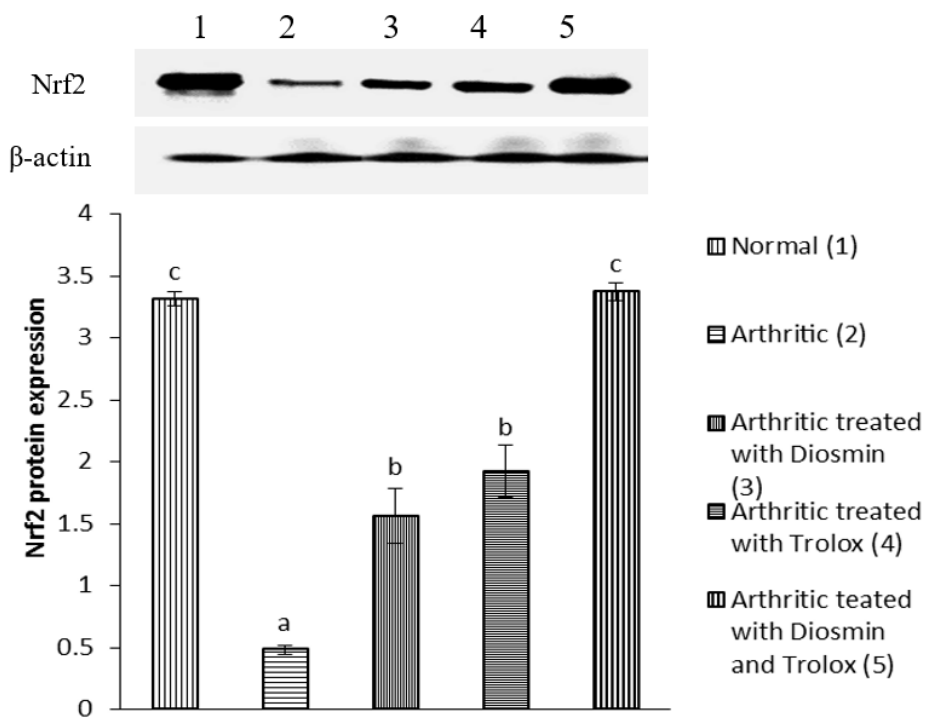
Figure 7. Effect of diosmin, trolox and their combination on Nrf2 protein expression level in CFA-induced arthritic rats. Means that have the same symbol (s) are not significantly different ( n = 3).